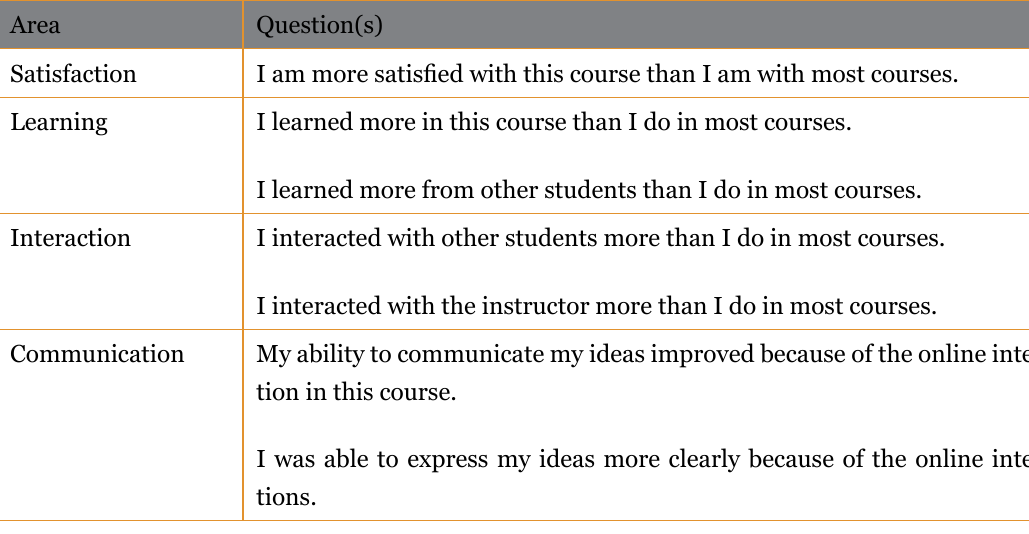
Questions Analyzed with Binary Logistic Regression